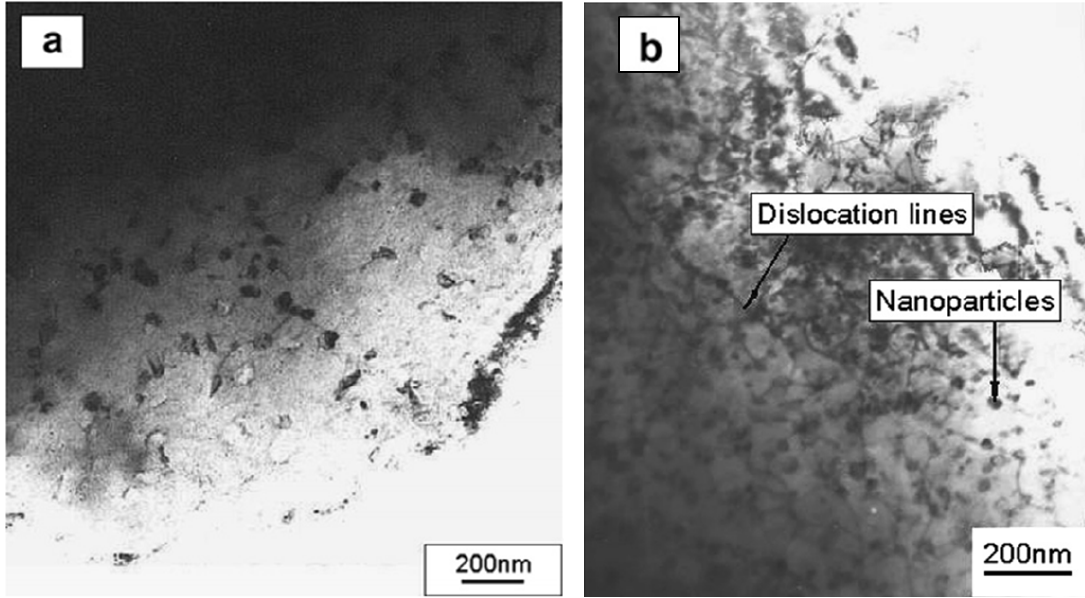
Figure 2: (a) the uniformly distributed Al 2 O 3 +Al 3 Z r nanodispersoids inside the grain (b) the pinned dislocations by the nanoparticles